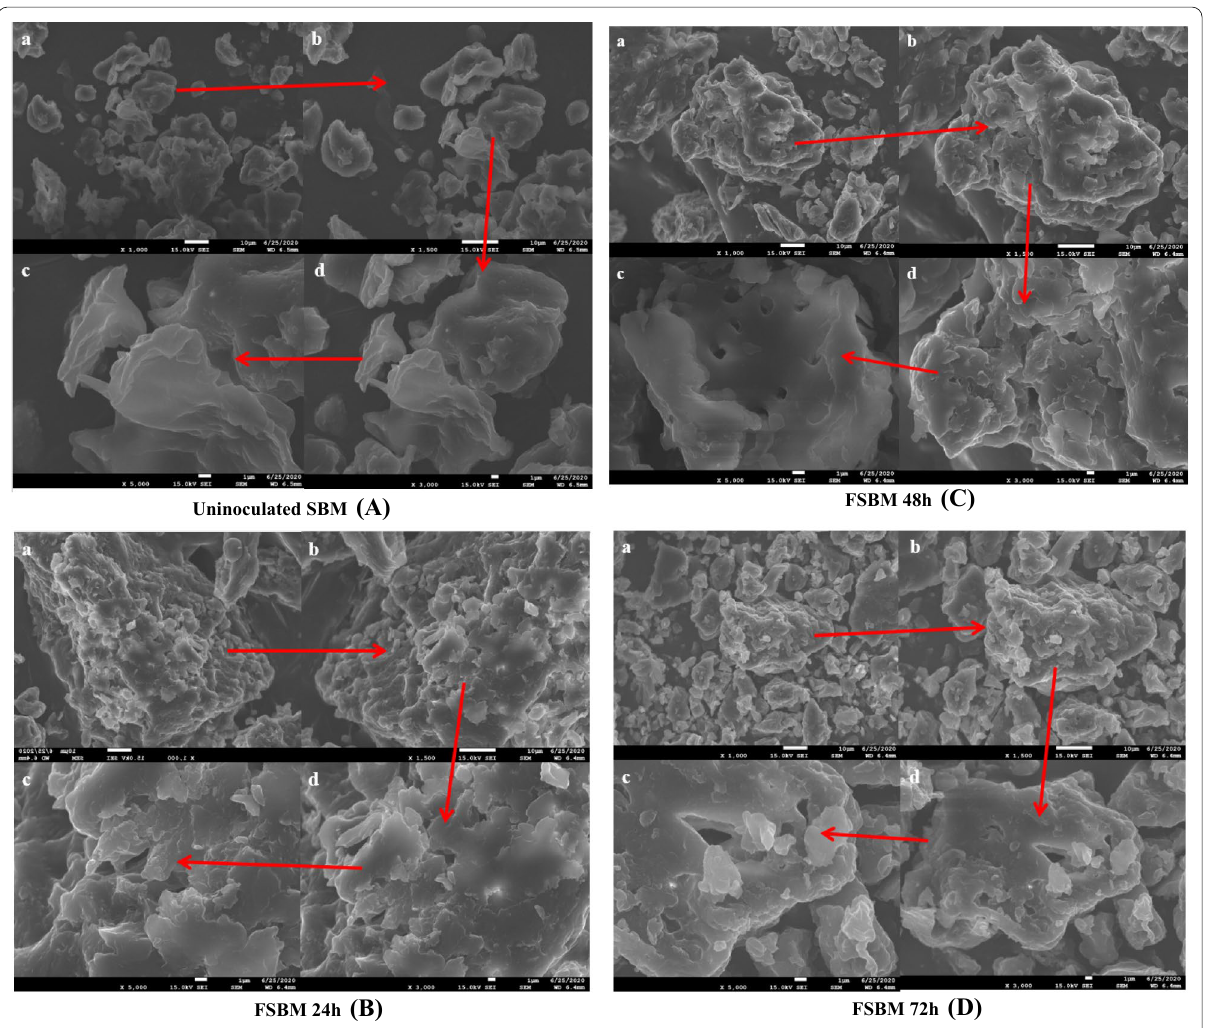
Fig. 4 SEM image of uninoculated SBM and FSBM during two-stage fermentation. a Uninoculated SBM; b the SBM was inoculated with B. velezensis 157 and fermented at 37 °C for 24 h; c the first-stage fermentation was inoculated with B. velezensis 157, incubated at 37 °C for 24 h, then were inoculated with L. plantarum BLCC2-0015 and fermented under anaerobic conditions at 37 °C for another 24 h; d the first-stage fermentation was inoculated with B. velezensis 157, incubated at 37 °C for 24 h, then were inoculated with L. plantarum BLCC2-0015 and fermented under anaerobic conditions at 37 °C for another 48 h. All the images were at 1000 ( a ), 1500 ( b ), 3000 ( c ) and 5000 ( d ) fold